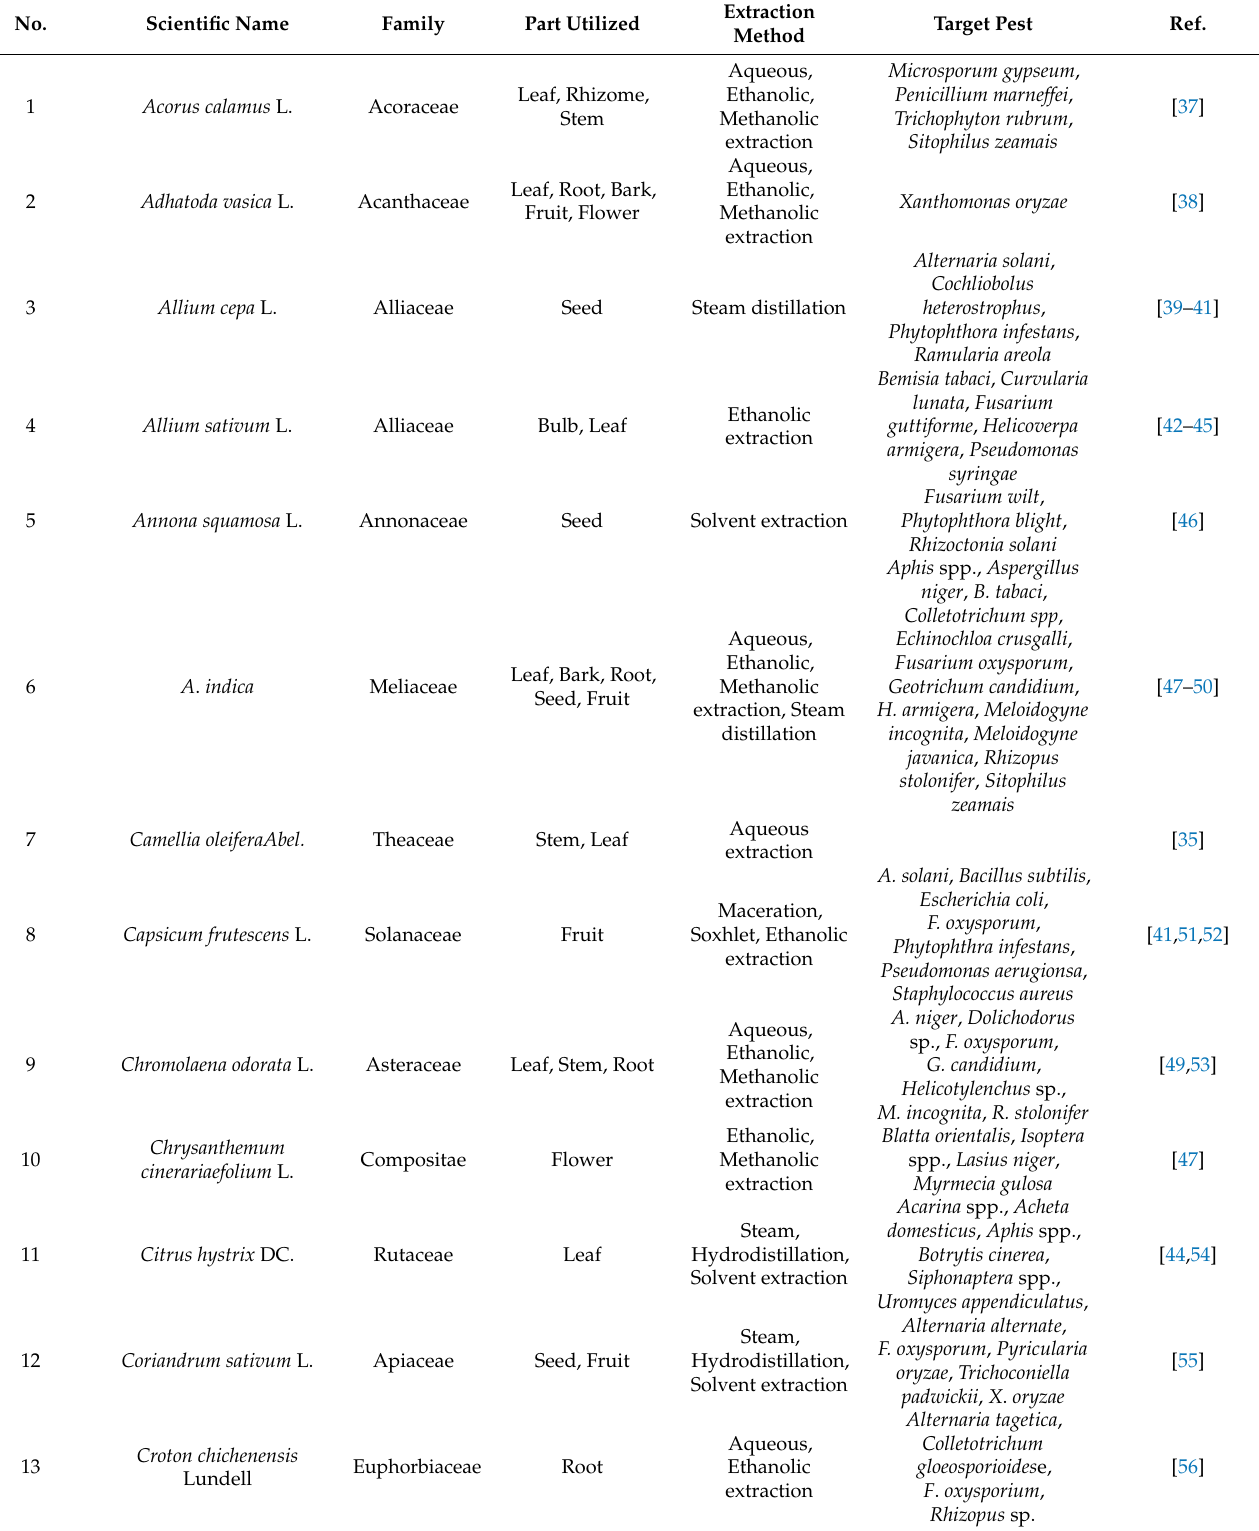
Table 1. Some botanicals, parts used, and extraction methods against targeted pests and